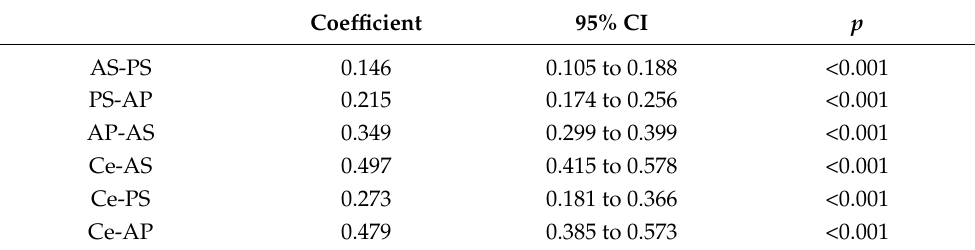
Table 4. Linear multiple regression analysis of CT variables associated with three-dimensional annulus area: estimated model coefficients and statistical significance of the independent